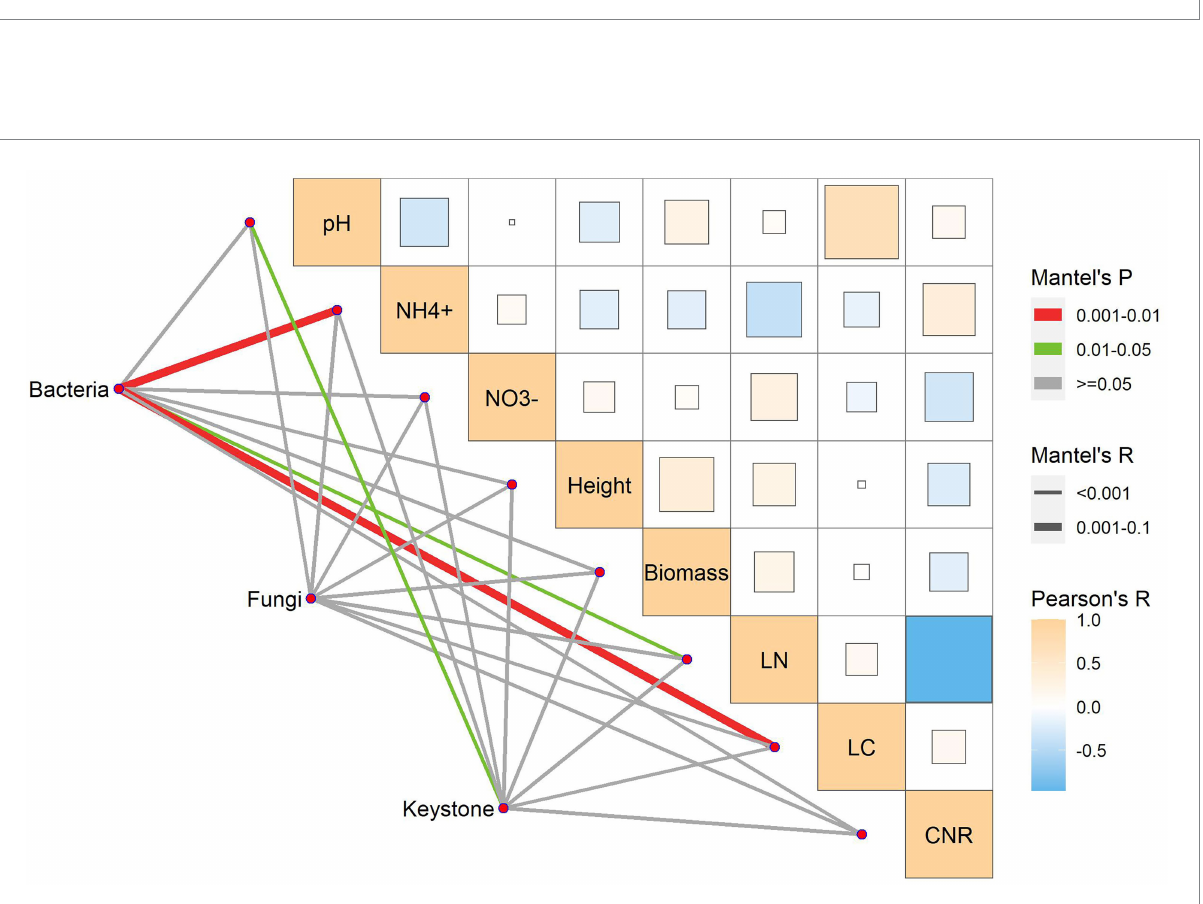
FIGURE 6 Mantel test for the associations of bacteria, fungi, and keystone species with soil abiotic properties and plant